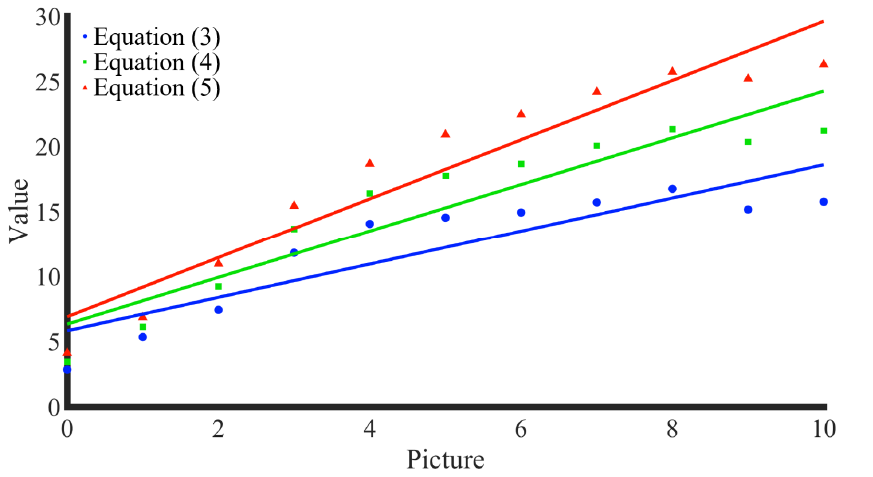
Figure 17. The relationship between the evaluation value and the degree of image blurring when the image contents are the same.